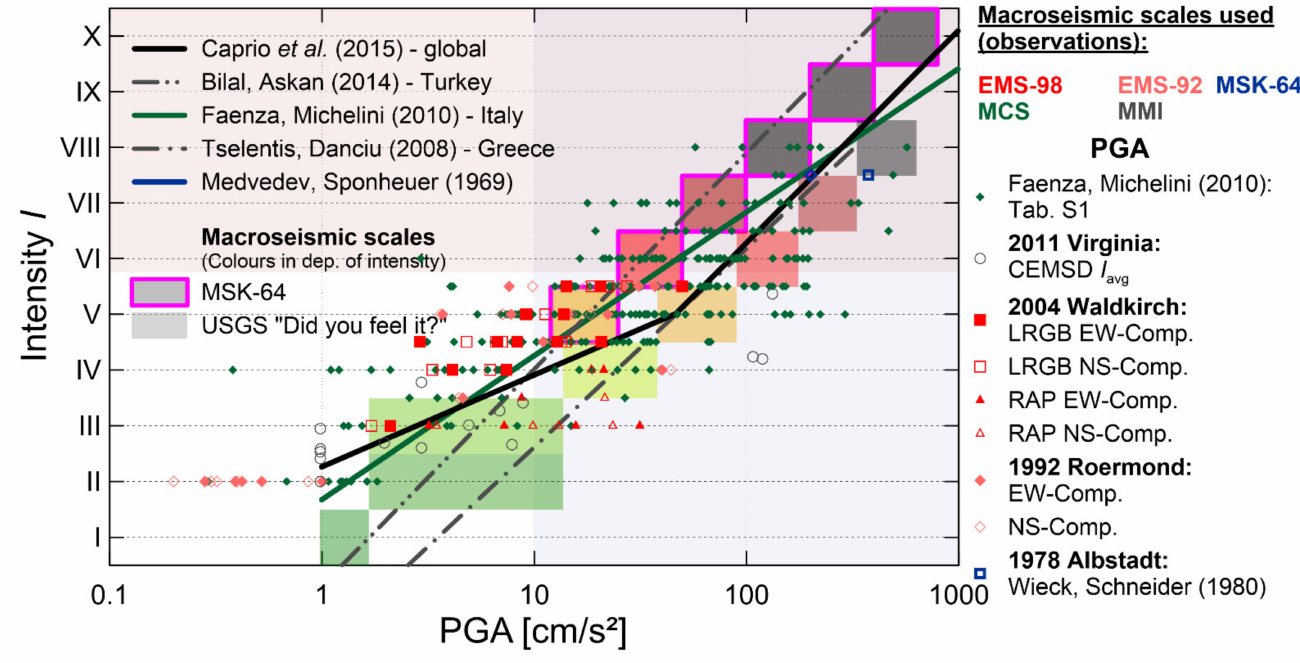
Figure 9. Example of a comparison of the peak ground acceleration ( PGA ) measurements for the 1978 Albstadt, 1992 Roermond, 2004 Waldkirch and 2011 Virginia earthquakes and the database of Faenza and Michelini in 2010